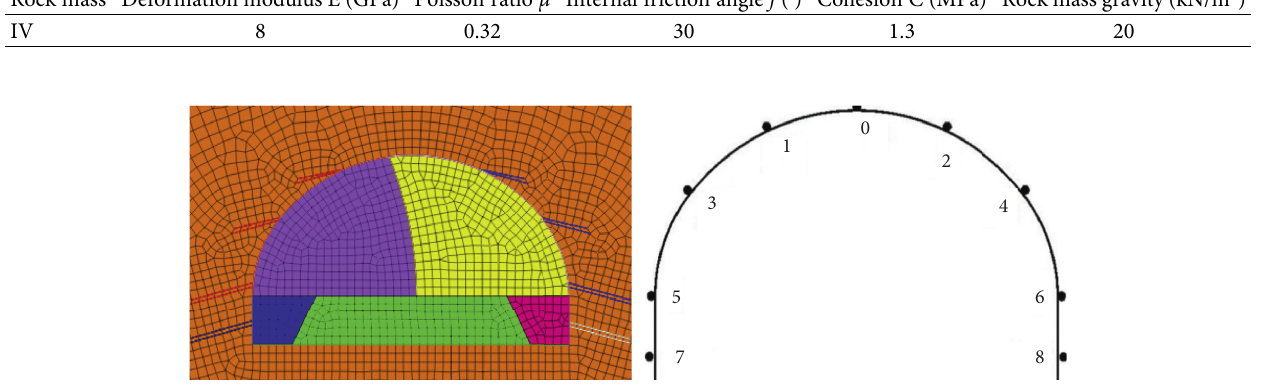
Figure 20: YK2+449 section